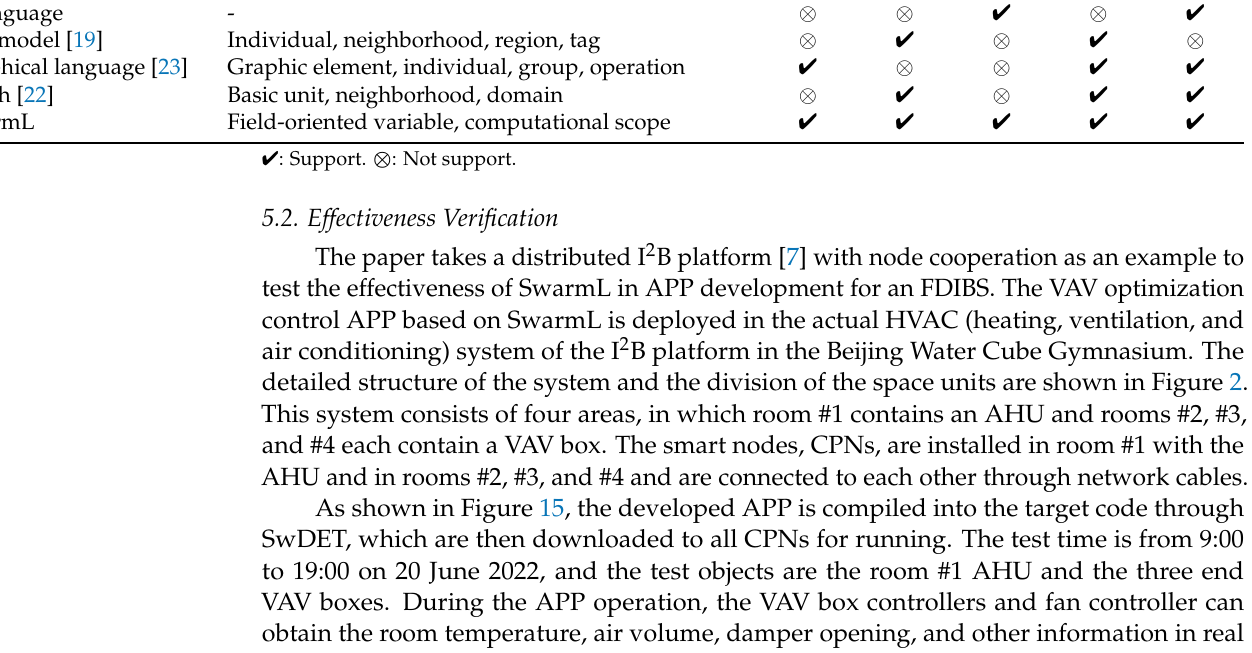
Table 2. Comparison between SwarmL and existing development methods. Development